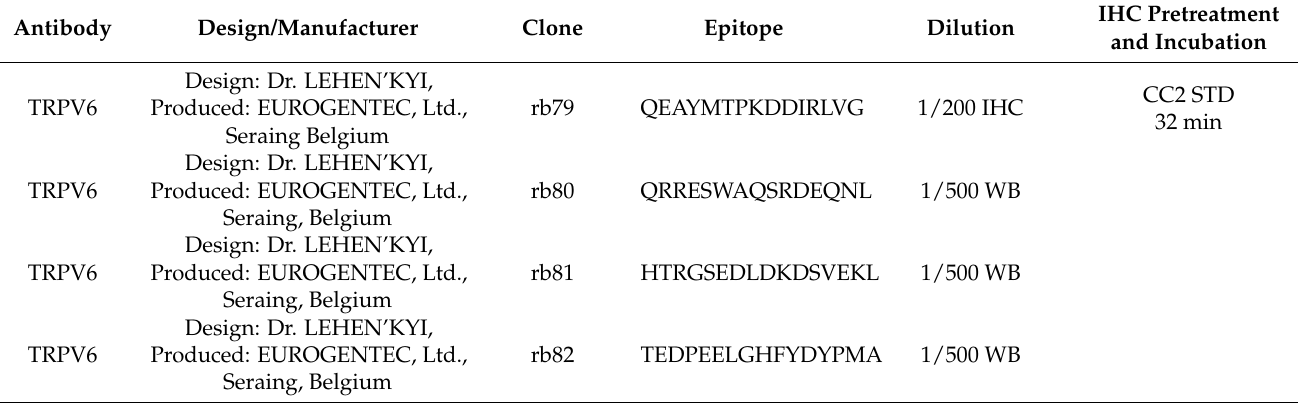
Table 4. List of antibodies, their epitopes, and conditions of use in the case of WB and/or IHC.